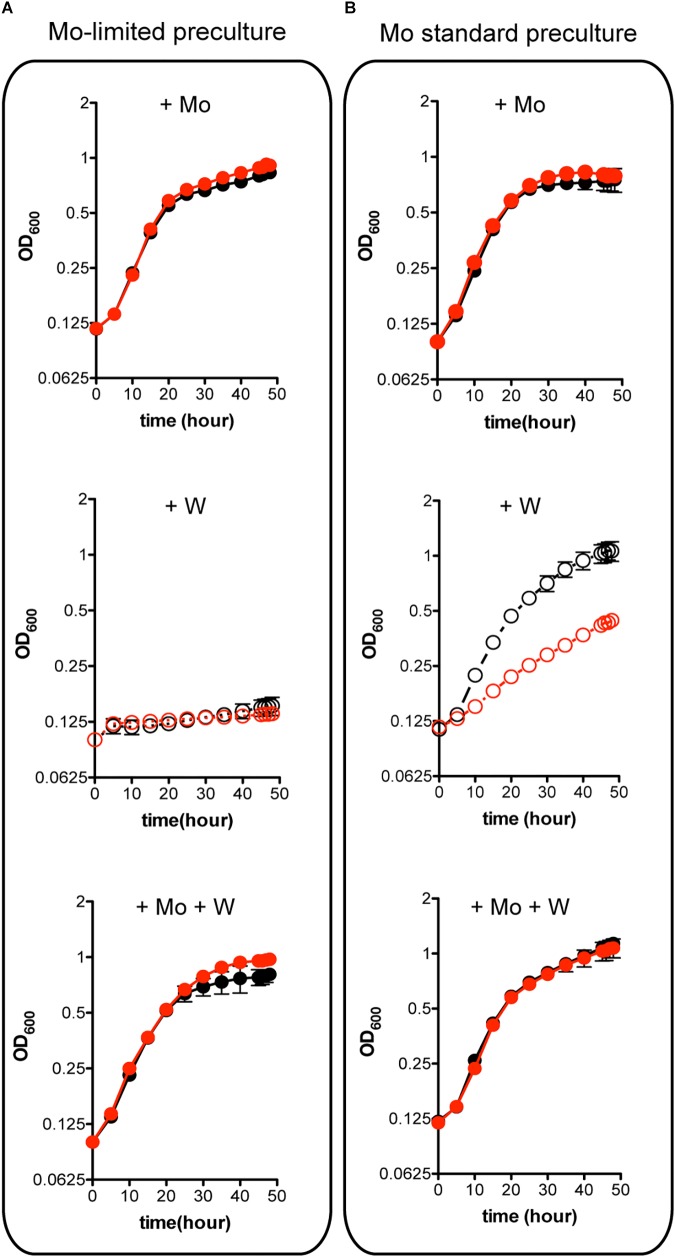
Effect of W on the diazotrophic growth of an A. vinelandii
ΔmosAB strain. Mo-starved (A) or Mo standard (B) precultures of A. vinelandii DJ (wild type; black symbols) or UW394 (ΔmosAB, red symbols) were inoculated into Burk’s modified N-free medium containing 1 μM molybdate (close symbols) or 4 nM molybdate (open symbols). One μM tungstate was included when indicated and all media contained 1 μM vanadate. Data represent mean ± standard deviation of three independent experiments.